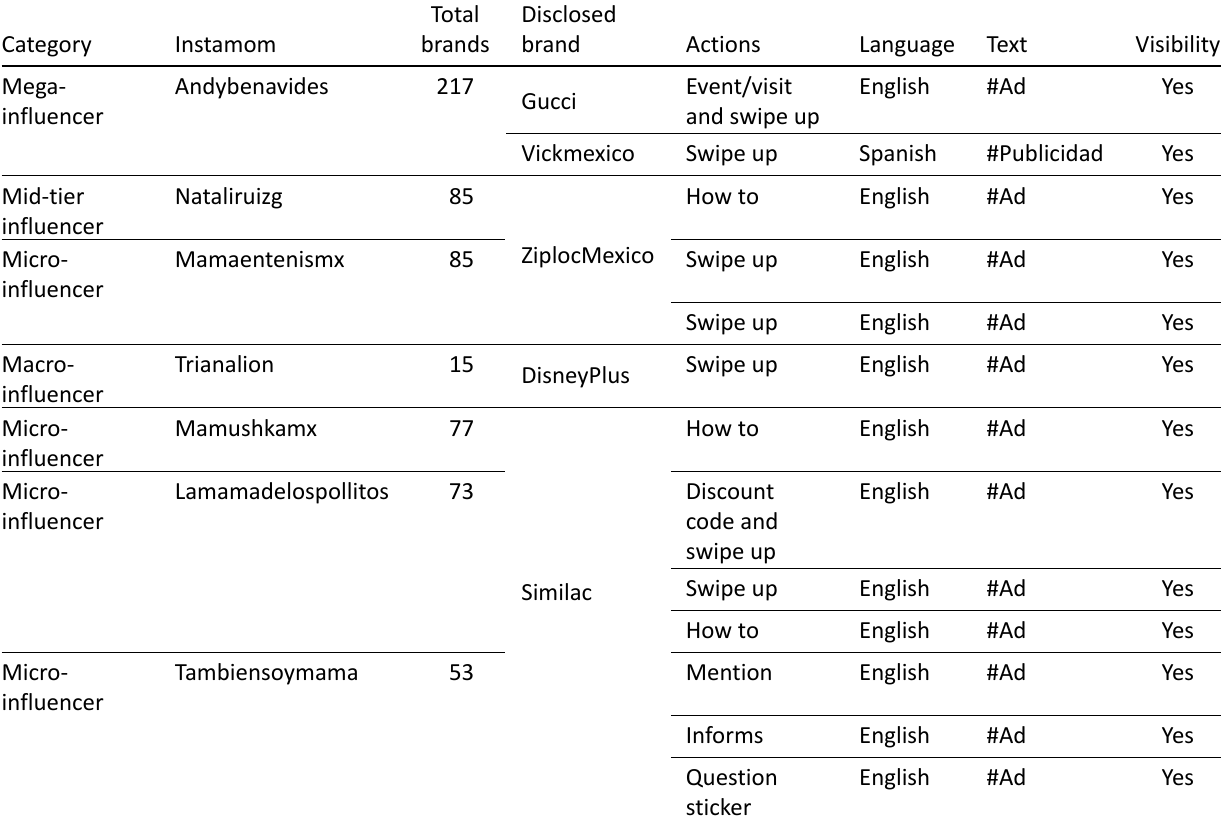
Table 5. Sponsorship disclosure by Instamoms in stories.